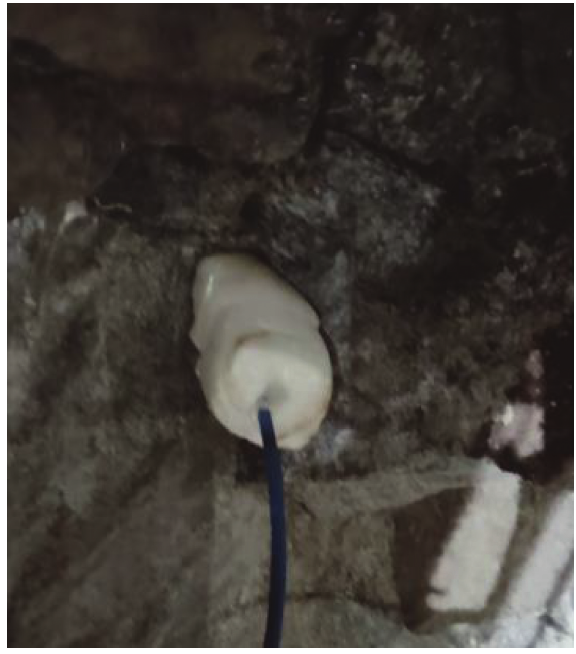
Figure 15: Site installation and burying.